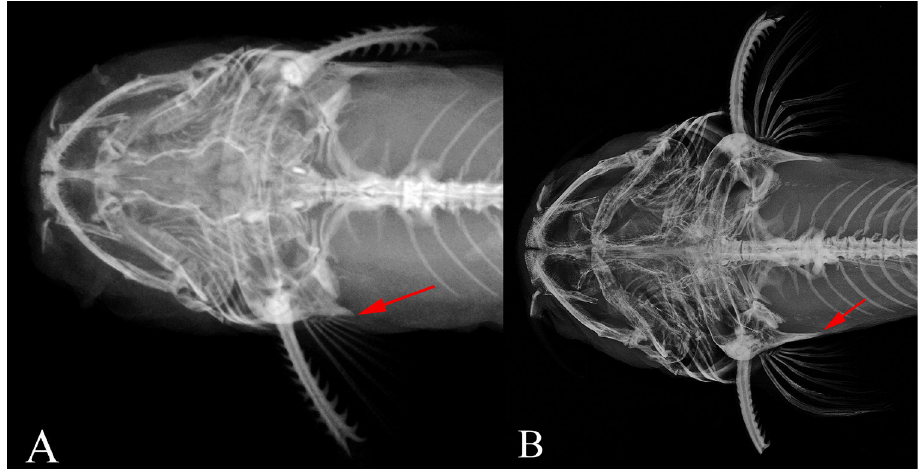
FIGURE 2 | Posterior cleithral process (red arrows) of A . Rhyacoglanis rapppydanielae , holotype,